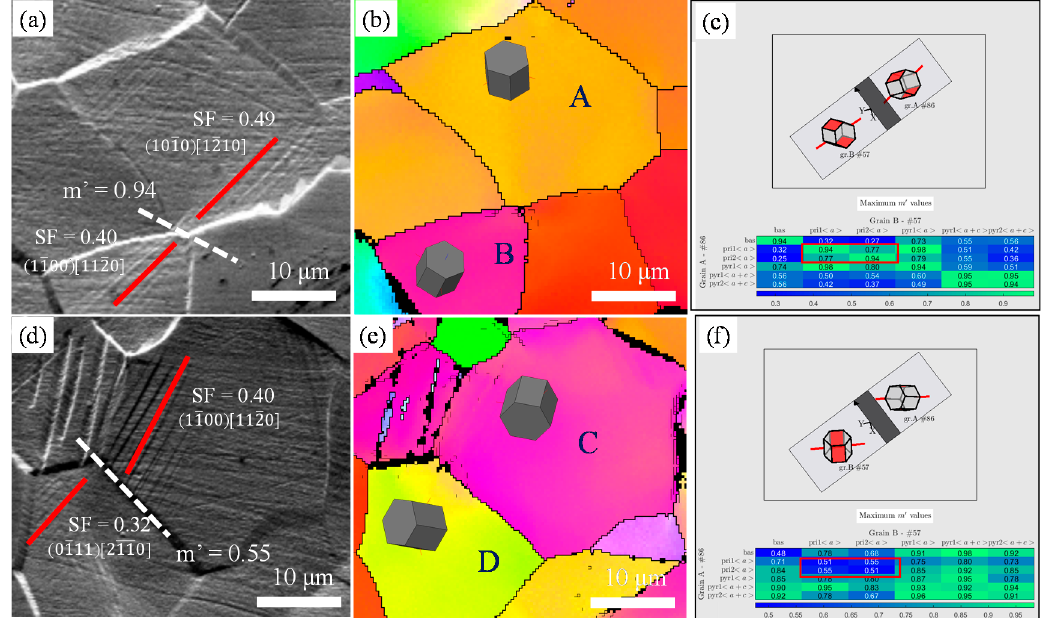
Figure 5. Slip transmission behavior between different grains: ( a , d ) SEM with the slip trace and SF of the activated slip systems; ( b , e ) IPF; ( c ) m (cid:48) calculation between grains A and B; ( f ) m (cid:48) calculation between grains C and D.